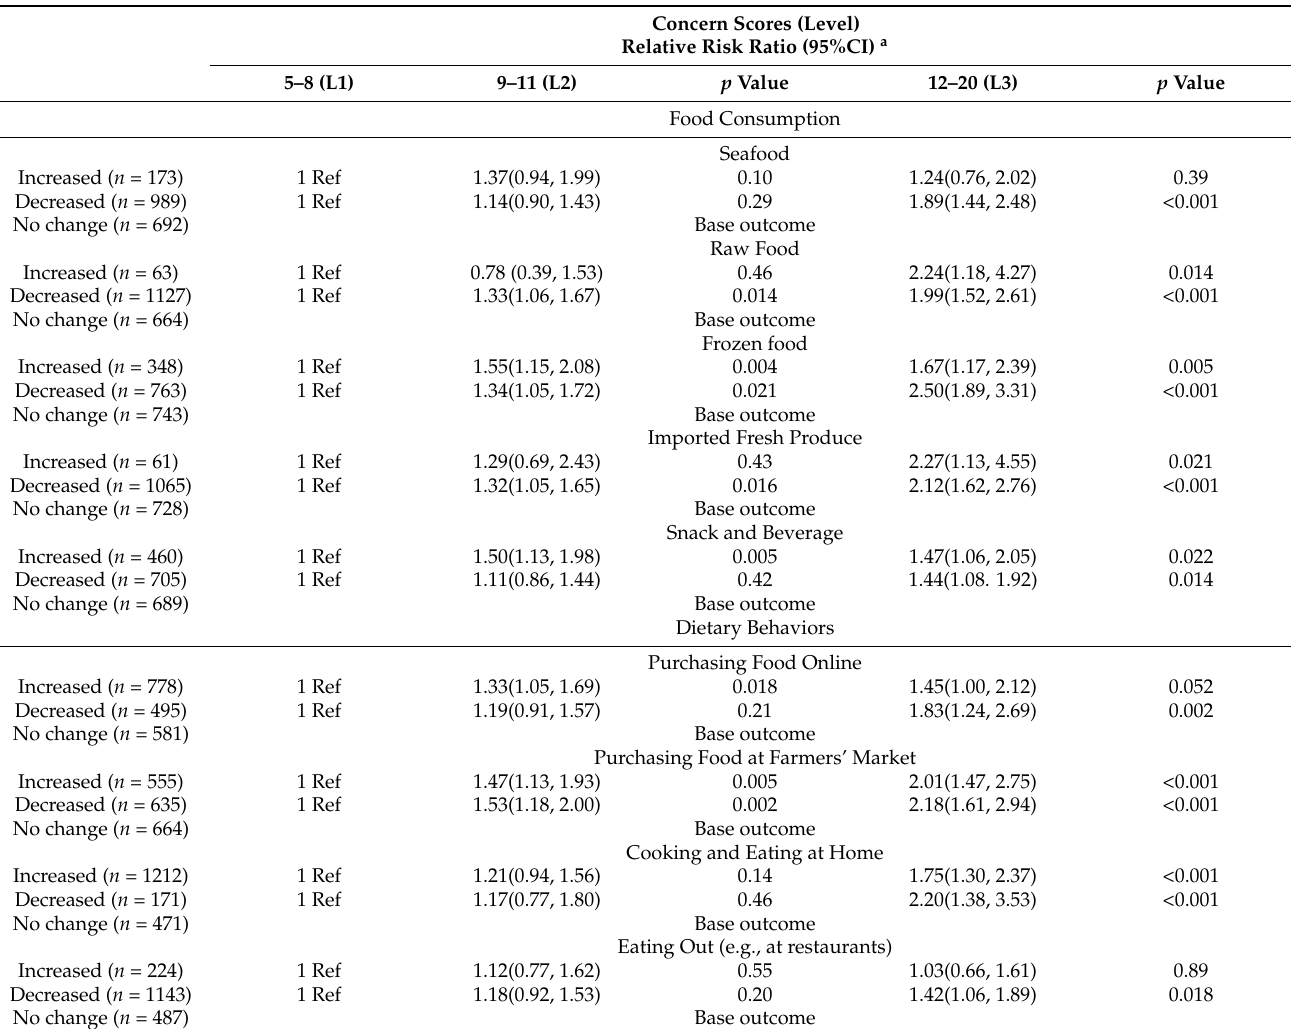
Table 4. Frequency of Food Consumption and Dietary Behaviors Comparing to the Same Period in the Previous Year